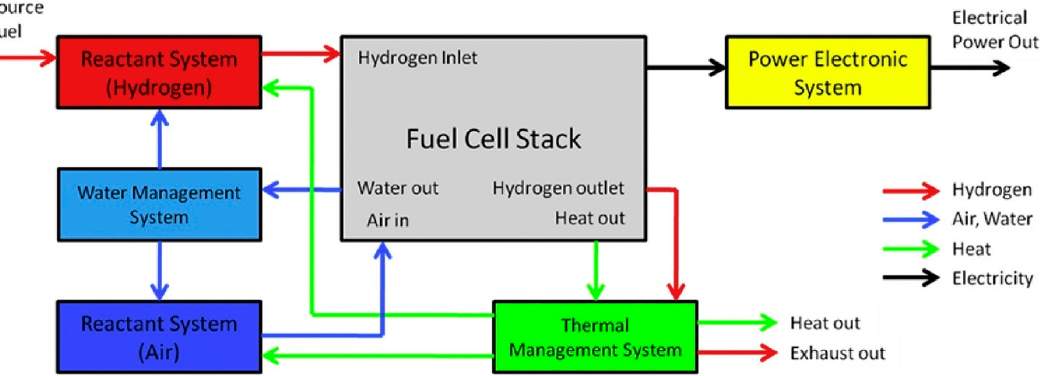
Figure 10. PEMFC schematic diagram [83]. Republished with permission from Elsevier (License no: 5398690664019).